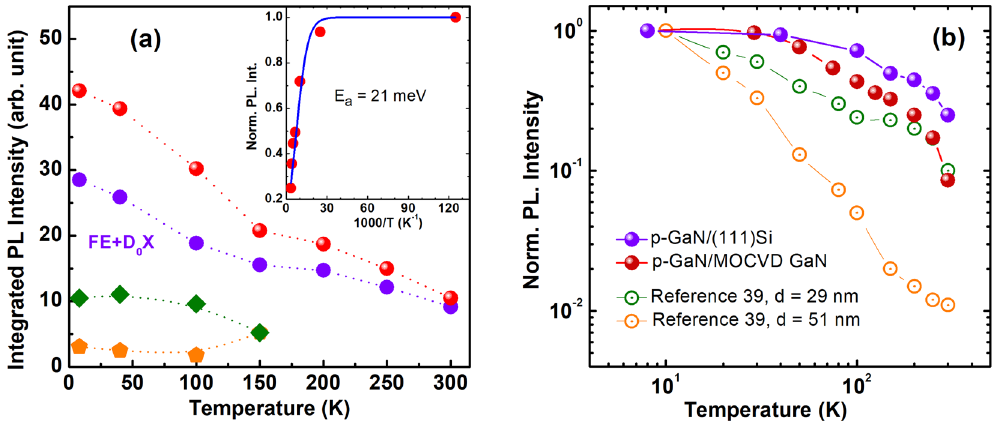
Figure 5. Evolution of the PL intensity against temperature measured in different samples. ( a ) Integrated PL intensity of different bands in p-GaN/(111)Si sample: red spheres correspond to the total spectral integration, purple dots, green diamonds and orange pentagons correspond to (FE + D 0 X), I 1 and I 2 related transitions, respectively. Note the thermal equilibrium reached after 150 K. Inset: Arrhenius plot of the PL intensity, which corresponds to an activation energy about 21 meV that is close to the free exciton binding energy of bulk GaN. ( b ) Normalized PL intensity for our two porous GaN samples in comparison with the results reported by Zettler et al . for GaN nanowires with different diameters 39 . Dotted and solid lines are guides to the eyes.